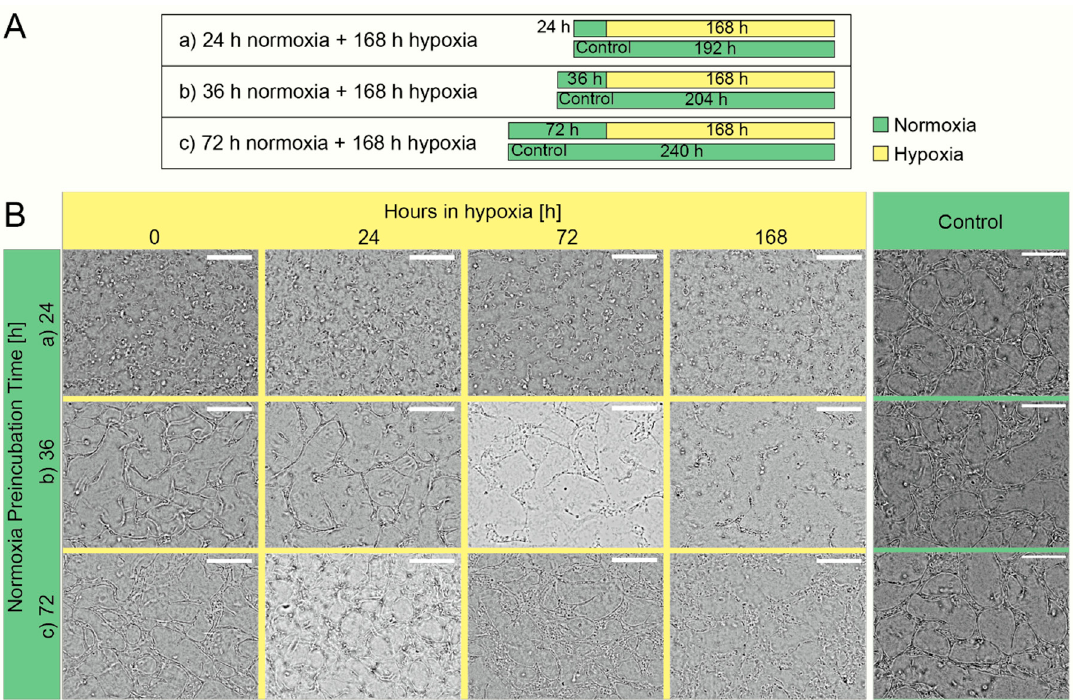
Figure 5. Vascularization under di ff erent conditions of preincubation in normoxia. ( A ) Time scheme of the cell culture at di ff erent preincubations in normoxia followed by hypoxia transitions. The cells are kept in preincubation in normoxia for 24, 36, and 72 h prior to the transition to hypoxic conditions for 168 h. Each condition was compared with cells maintained in normoxic conditions (Control). ( B ) Temporal evolution of the lumens at di ff erent normoxia preincubations. The lumenization increased with the time in normoxic preincubation. Scale bar = 150 µm.